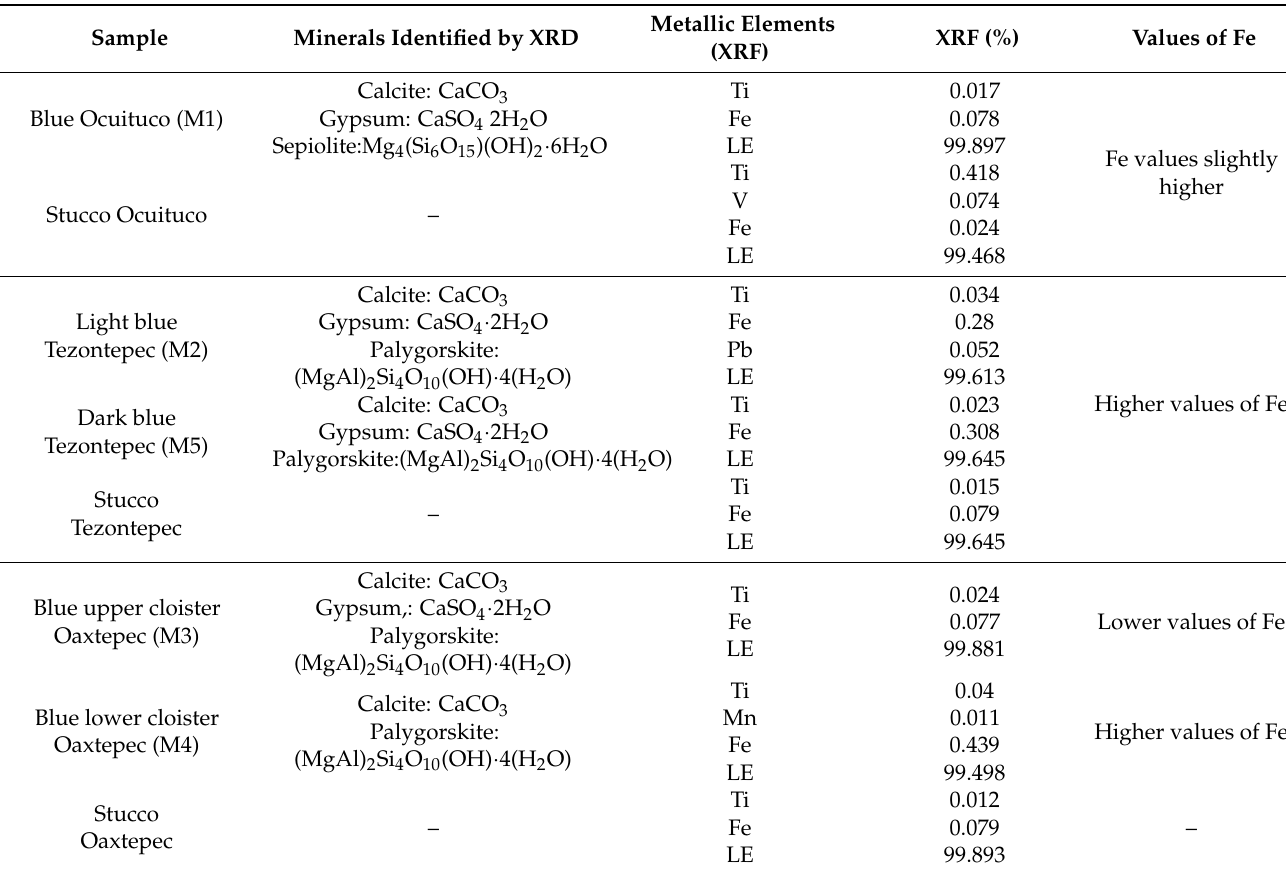
Table A2. XRF data of blue samples cantaining palygorskite or sepiolite compared with XRF data of stucco without painting. Fe values can be